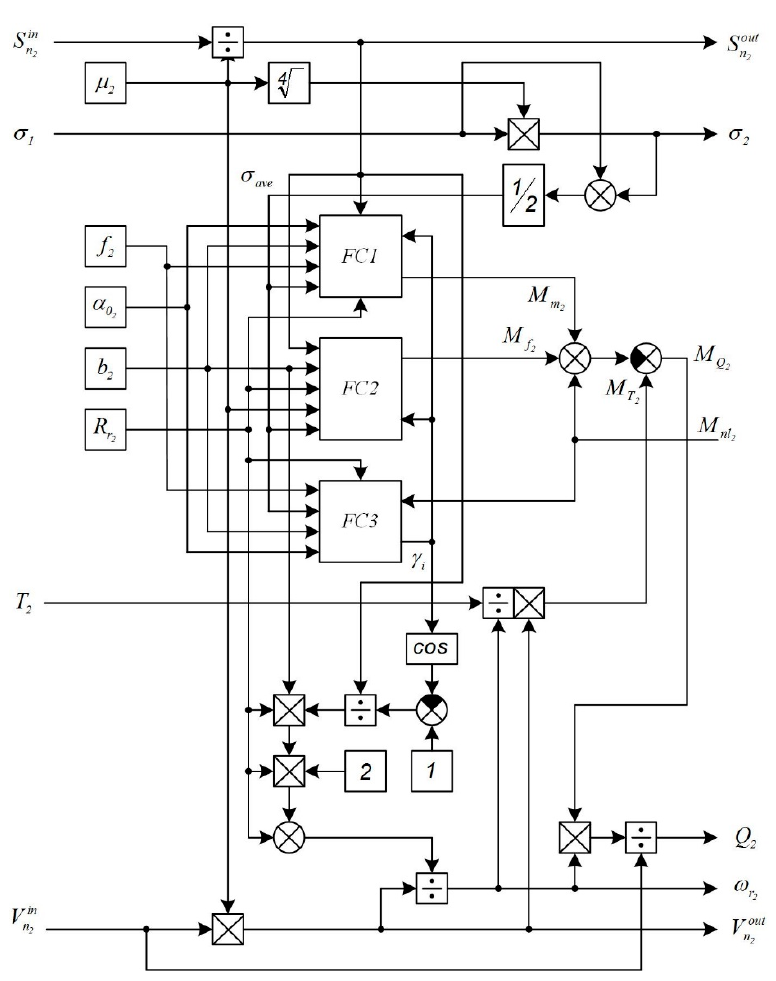
Figure 7. Block diagram of the mathematical model of the idle stand deformation zone.